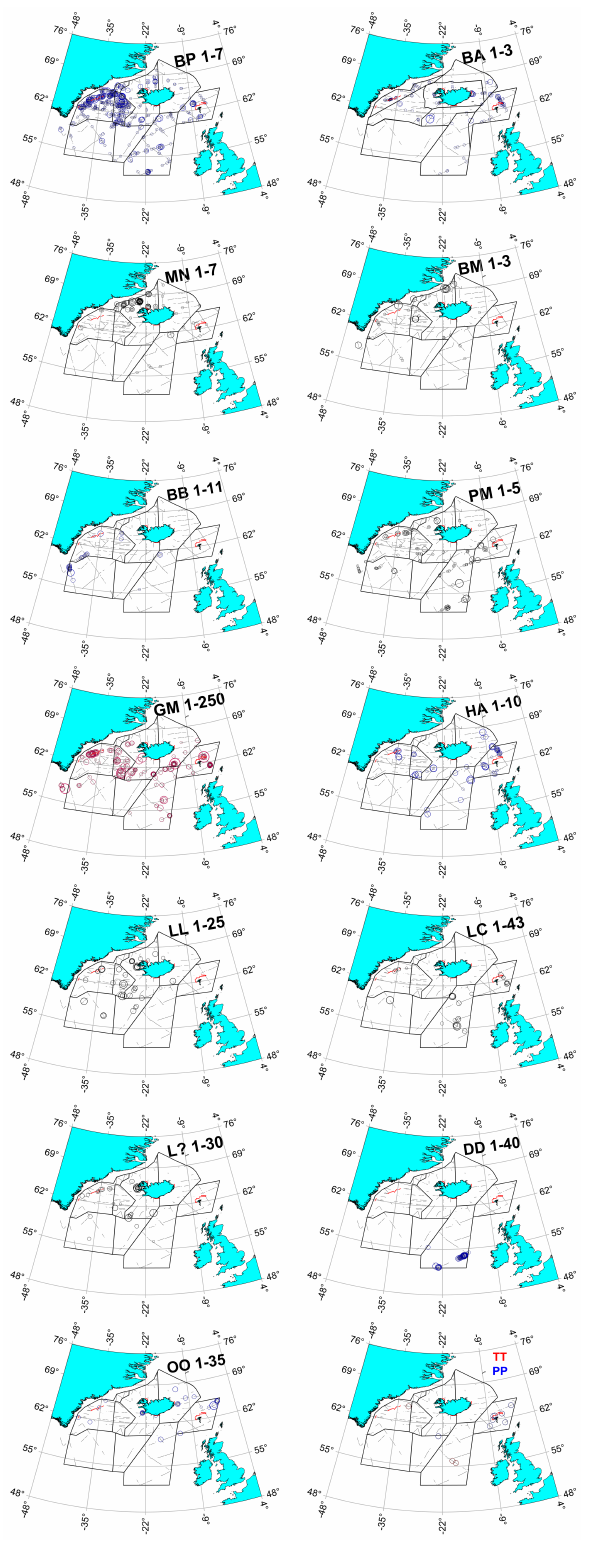
Figure 4. Sightings of cetaceans. Symbol size is proportional to group size indicated on the panels. BP – fin whale;, BA – common minke whale; MN – humpback whale; BM – blue whale; BB – sei whale; PM – sperm whale; GM – long-finned pilot whale; HA – northern bottlenose whale; LL – white-beaked dolphin; LC – white-sided dolphin; L? – unidentified Lagenorhynchus spp. dolphin; DD – short-beaked common dolphin; OO – killer whale; TT – common bottlenose dolphin; PP – harbour porpoise.